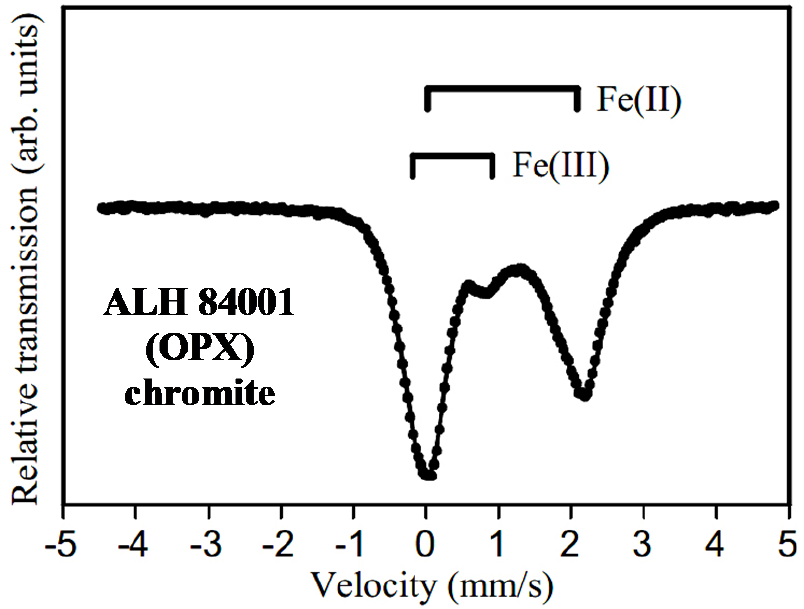
Figure 13. Room temperature Mössbauer spectrum of chromite separate from ALH 84001 OPX. Indicated spectral components are the result of the fit. Adapted from [35].